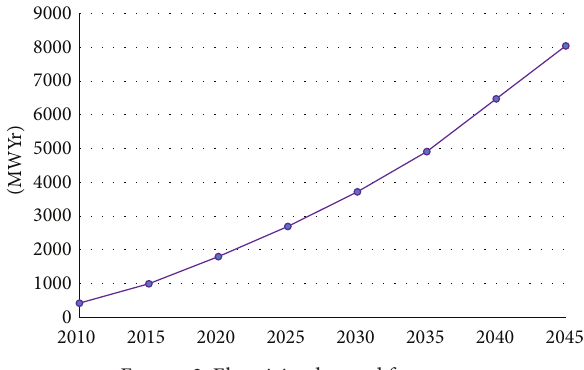
Figure 2: Electricity demand